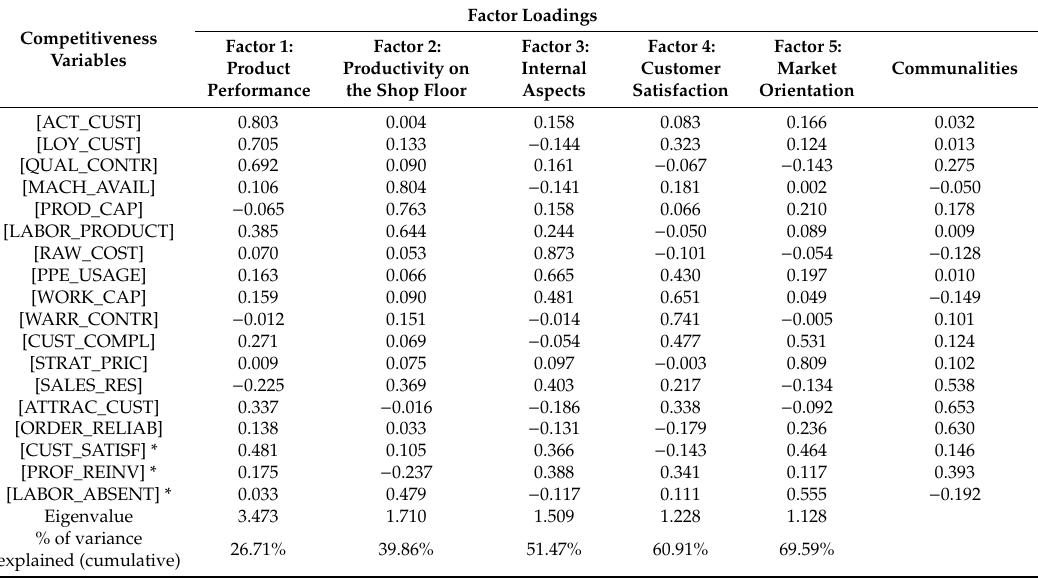
Table 4. Rotated factor-loading matrix for competitiveness model.